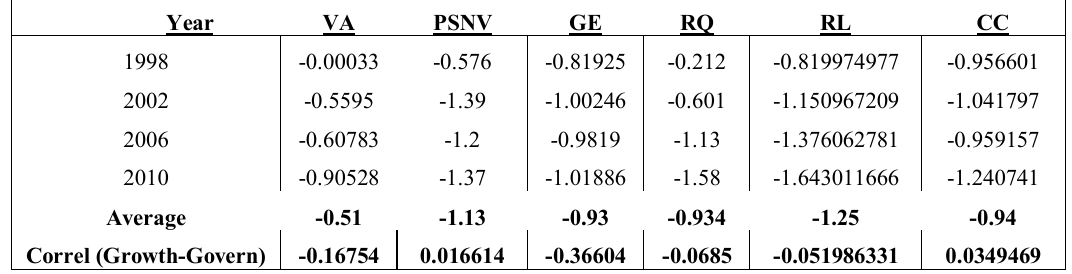
Table 2: Components of Governance Indicators for Venezuela